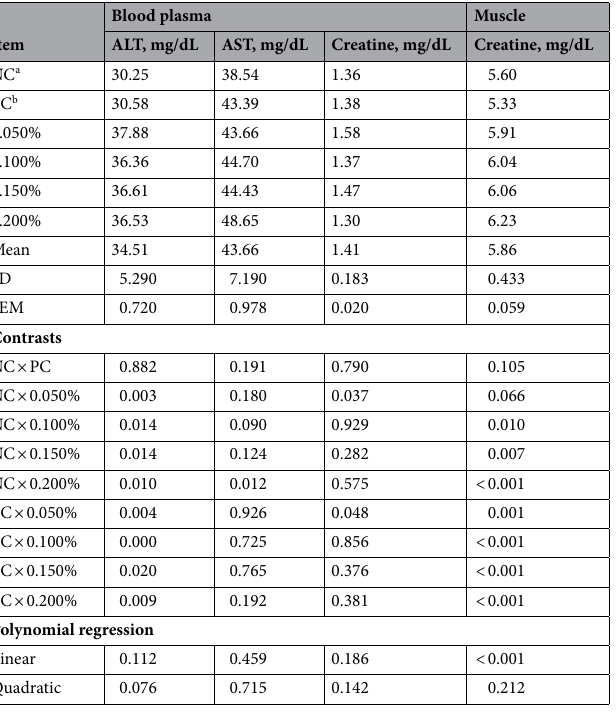
Table 5. Concentrations of alanine aminotransferase (ALT), aspartate aminotransferase (AST), and creatine in blood plasma, as well as creatine concentration in longissimus lumborum muscle of 75–100 kg barrows fed diets containing different levels of inosine-5-monophosphate (5 ′ -IMP) and metabolizable energy (ME). a Negative control (0.00% 5 ′ -IMP and 3200 kcal ME/kg). b Positive control (0.00% 5 ′ -IMP and 3300 kcal ME/kg).